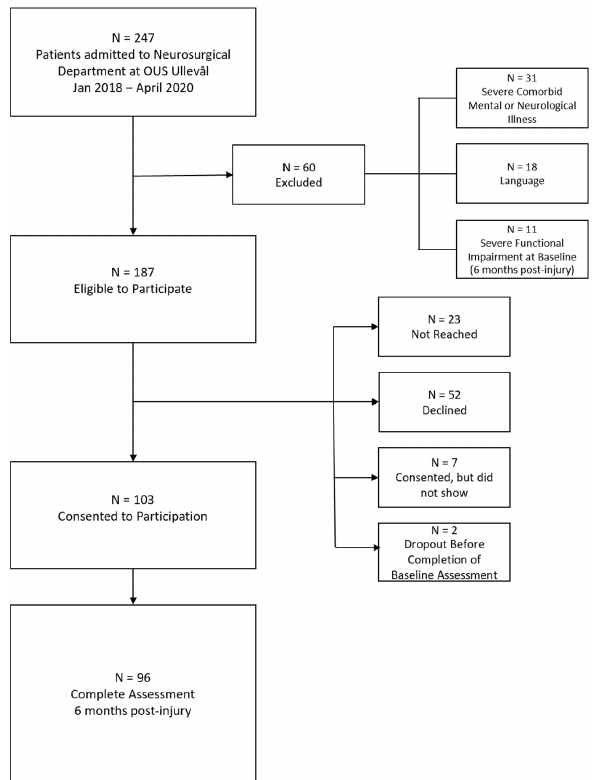
Figure 1. Flow chart of the inclusion and exclusion process. From a sample of 187 eligible patients, 103 participants (55%) consented to participate, and 96 ended up with a complete dataset. The average age was 45.3 (SD = 13.9), with a mean educational attainment of 13.5 years (SD = 2.3). The sample consisted of 77 (80.2%) males and 19 (19.8%) females. On the ASA-PS, 69 patients (71.9%) were classified as healthy prior to injury, 19 (19.8%) as having moderate organic disease not impairing function, and eight patients (8.3%) as having severe organic disease. The sample mean of GCS registered at injury site or at admission to the hospital pre- intubation was 10.7 (SD = 3.6), while GCS registered upon discharge from the acute hos- pital was 14.4 (SD = 0.9). The sample mean Rotterdam CT score was 2.8 (SD = 0.9). Using the dichotomized AIS_head classification, 18 patients (18.8%) were classified within the less severe category, and 78 (81.3%) within the very severe category. Upon discharge from the acute hospital, GOS ratings based on medical records classified 39 patients (40.6%) with moderate disability, 56 (58.3%) with severe disability, and one patient (1.1%) as being in a vegetative state. Fifteen patients (15.6%) were discharged directly to their homes, 32 (33.3%) to a local hospital, and 49 (51%) were referred to a rehabilitation unit. The study assessment was conducted on average 205 days (SD = 28) since injury.